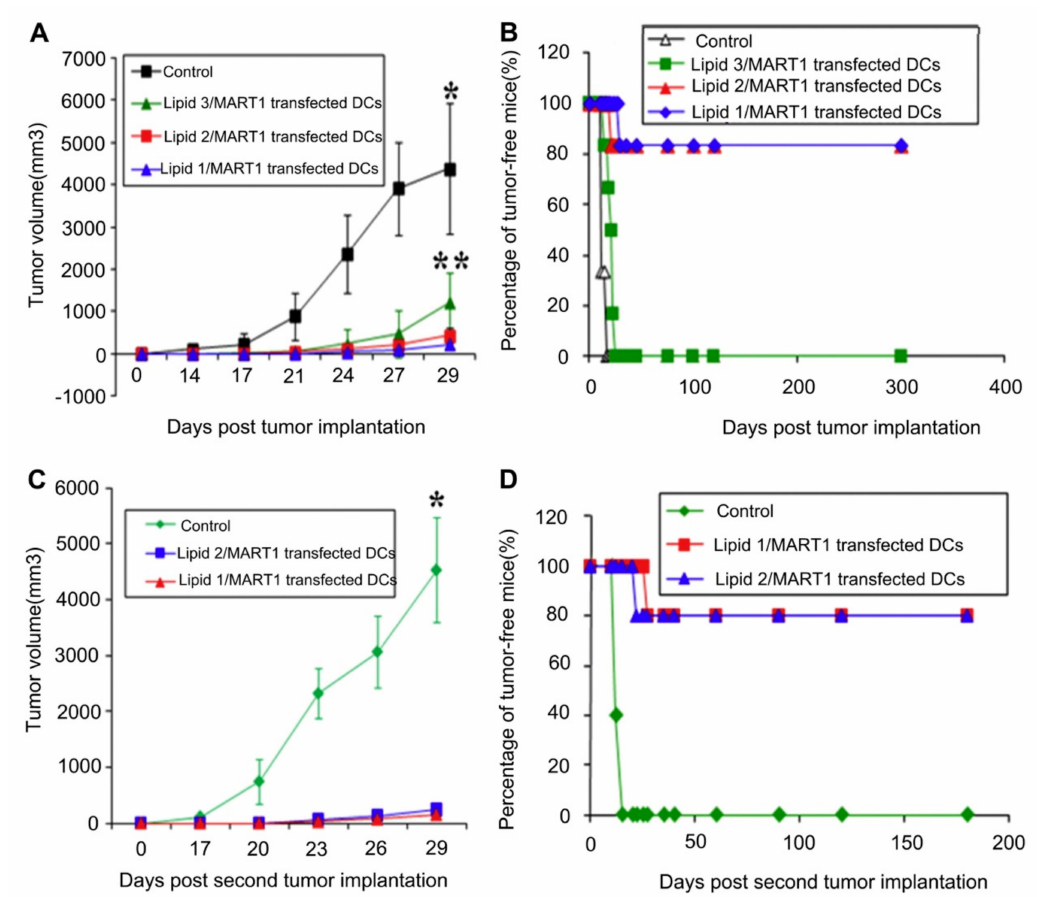
Figure 6. Long term tumor protection induced by immunization with DCs transfected ex vivo with melanoma DNA vaccine delivered via liposome NPs. A ) Mice were immunized twice with murine-bone-marrow-derived DCs (mbmDCs) pre-treated with DNA encoding a melanoma-associated antigen, p-CMV-MART1, demonstrating the induction of protective immunity against a lethal melanoma tumor challenge. B ) Percentage of tumor-free mice from the study mentioned above. C ) The immunized mice that survived the first tumor challenge described above for 120 days were challenged a second time with another lethal melanoma tumor. A notable memory response to the melanoma DNA vaccine was observed through prolonged tumor growth inhibition after the second lethal challenge. D ) Percentage of tumor-free mice remaining post-second lethal melanoma challenge. Data expressed as the means +/ - SD for n = 6 tumors (*P < 0.005 vs. tumor sizes for lipoplexes of lipids 1–3, **P < 0.005 vs. tumor sizes for lipoplexes of lipids 1 and 2). Reprinted with permission from R Srinivas, Biomaterials, published by Elsevier, 2012